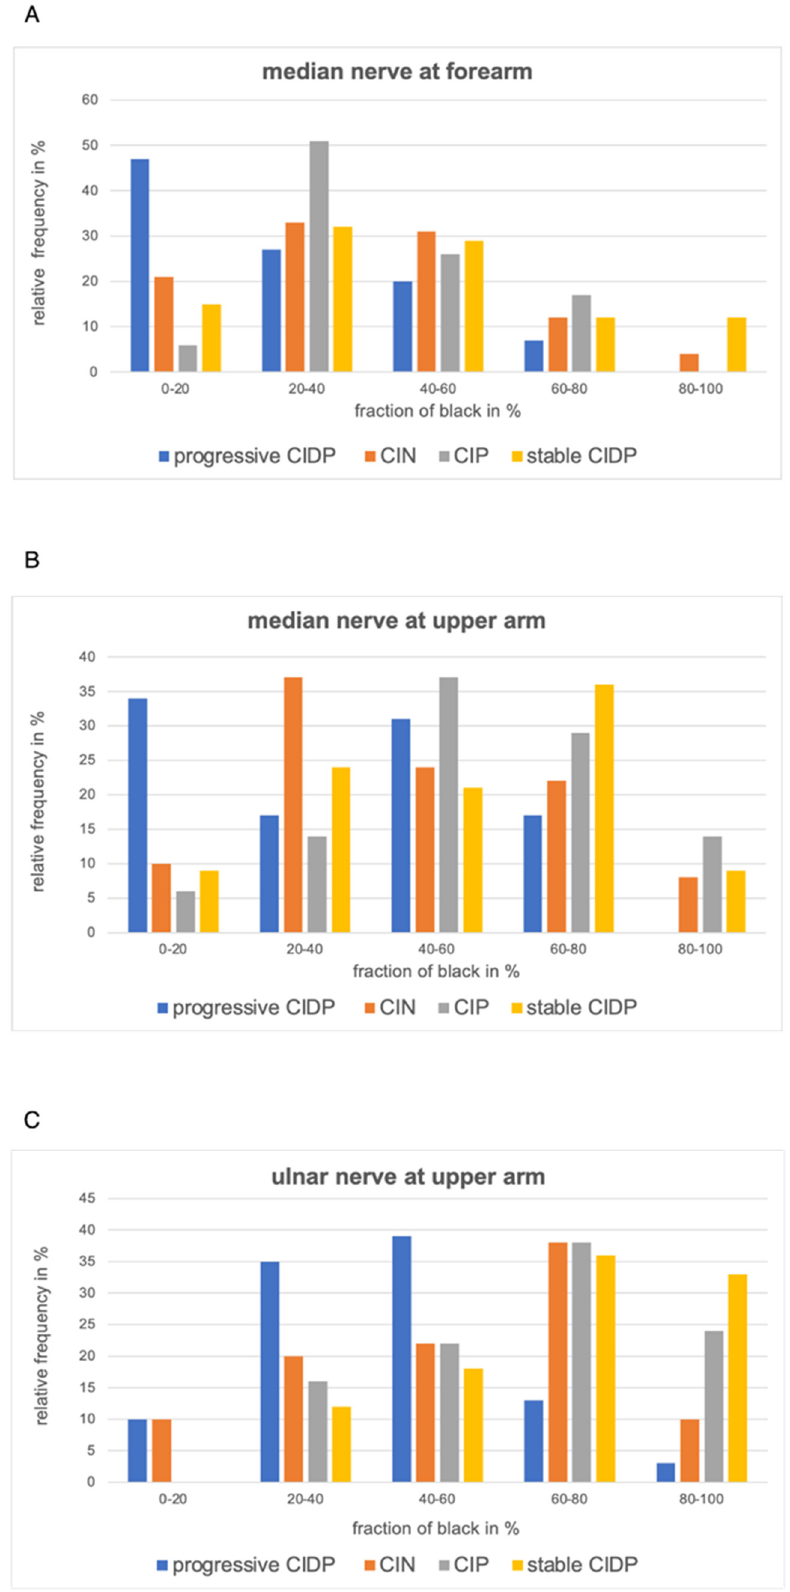
Figure 2. Relative frequency distribution of the fraction of black of the significant locations, ( A ) = median nerve in forearm, ( B ) = median nerve in upper arm, ( C ) = ulnar nerve in upper arm.